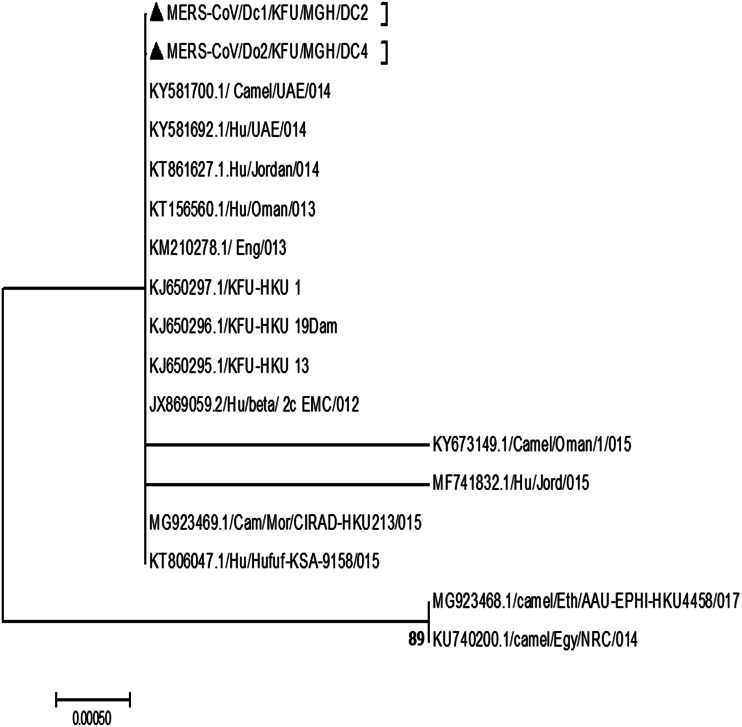
Phylogenetic analysis based on the partial MERS-CoV-N gene. Phylogenetic analysis is based on the partial MERS-CoV-N gene from dromedary camels sharing the habitat. The maximum likelihood based on the partial MERS-CoV-S sequences revealed these sequences clustered together and share a high degree of identity with other sequences reported from eastern Saudi Arabia, Qatar and Jordon reported in 2015. Our sequences are identified with black triangles.